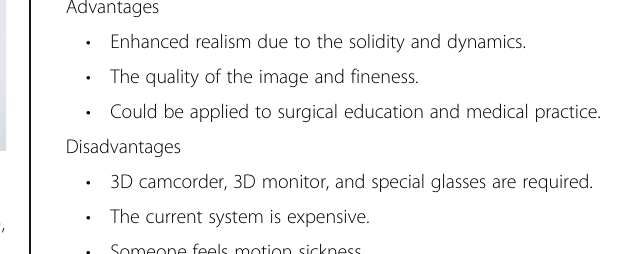
Table 2 Advantages and disadvantages of 3DHD